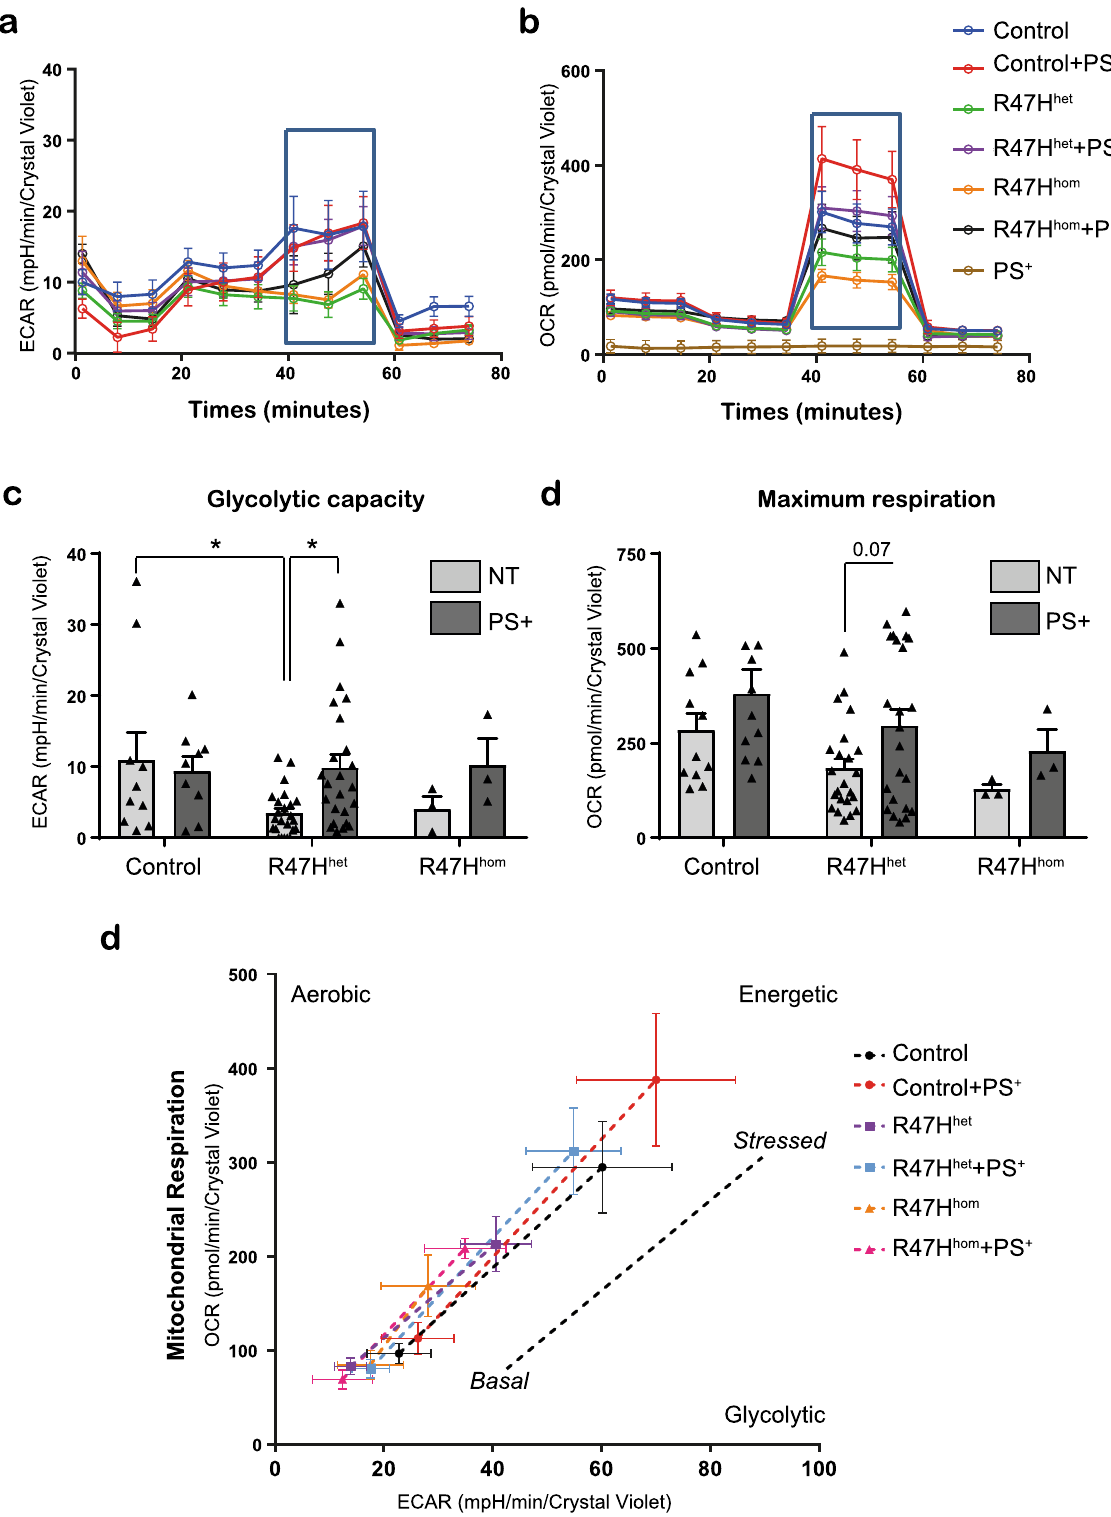
Figure 6. ( a ) The extracellular acidification rate (ECAR) and ( b ) oxygen consumption rate (OCR) were analysed in control and TREM2 R47H iPS-Mg for glycolysis and mitochondrial oxidation respectively. ( c ) Analysis of iPS-Mg glycolytic capacity identified significant deficits in the ECAR of TREM2 R47H lines when compared with controls; data are mean ± SEM, n = 3–24 cell lines from 3 individual experiments, * P < 0.05 (two-way ANOVA with Tukey’s correction). ( d ) Analysis of iPS-Mg maximal respiration identified reduction in the OCR of TREM2 R47H lines when compared with controls; data show mean ± SEM, n = 3–23 cell lines from 3 individual experiments, * P = 0.07 (two-way ANOVA with Tukey’s correction). ( e ) Metabolic potential of iPS-Mg following FCCP treatment shows induction from a resting aerobic phenotype to an activated stressed phenotype in control and R47H TREM2 lines; data are mean ± SEM, n =